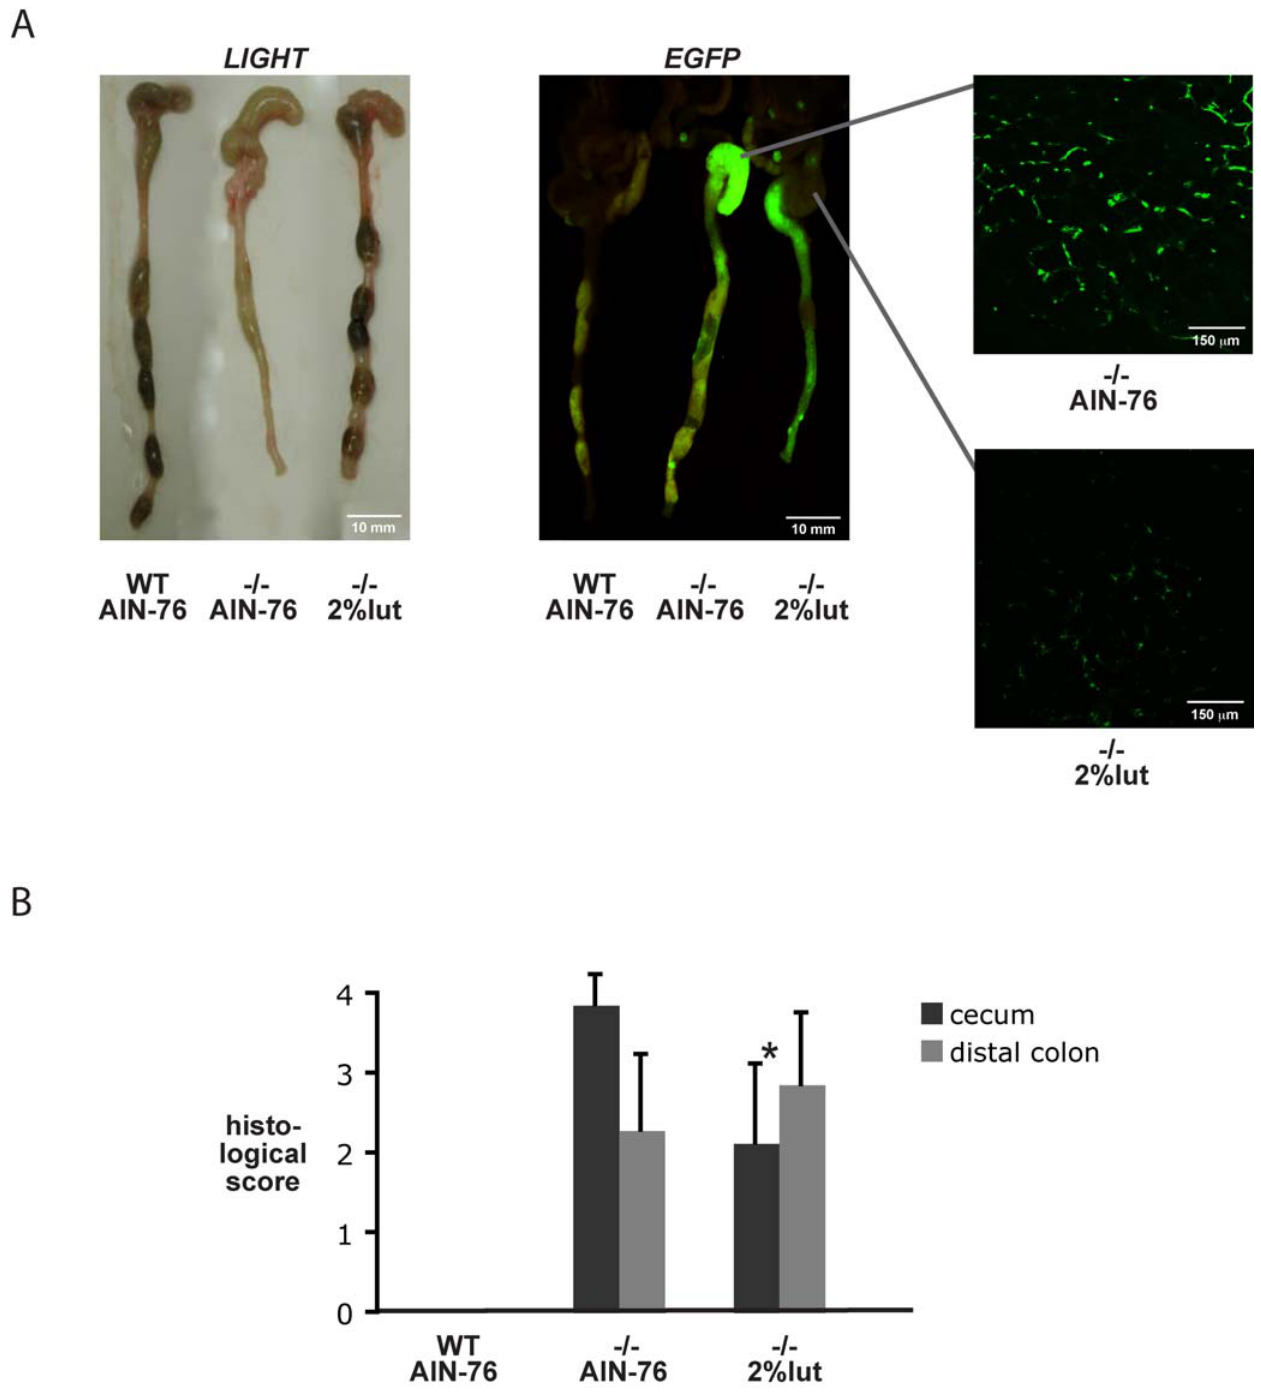
Figure 4. 2% luteolin diet ameliorates cecal colitis and decreases lamina-propria EGFP expression in SPF-associated IL-10 2 / 2 ;NF- k B EGFP mice. Germ-free IL-10 wt/wt ;NF- k B EGFP and IL-10 2 / 2 ;NF- k B EGFP mice were transferred to a specific-pathogen-free (SPF) environment and immediately placed on a diet containing 2% luteolin versus AIN-76 control chow (7/subgroup). After 4 weeks, mice were euthanized, and colonic EGFP-expression was imaged macroscopically and by confocal microscopy as described in figure 2 (A). Colonic histological sections from 4 weeks SPF-associated IL-10 wt/ wt ;NF- k B EGFP and IL-10 2 / 2 ;NF- k B EGFP mice were taken and scored as described in the Methods section (* p , 0.05 versus AIN-76 control chow) (B).